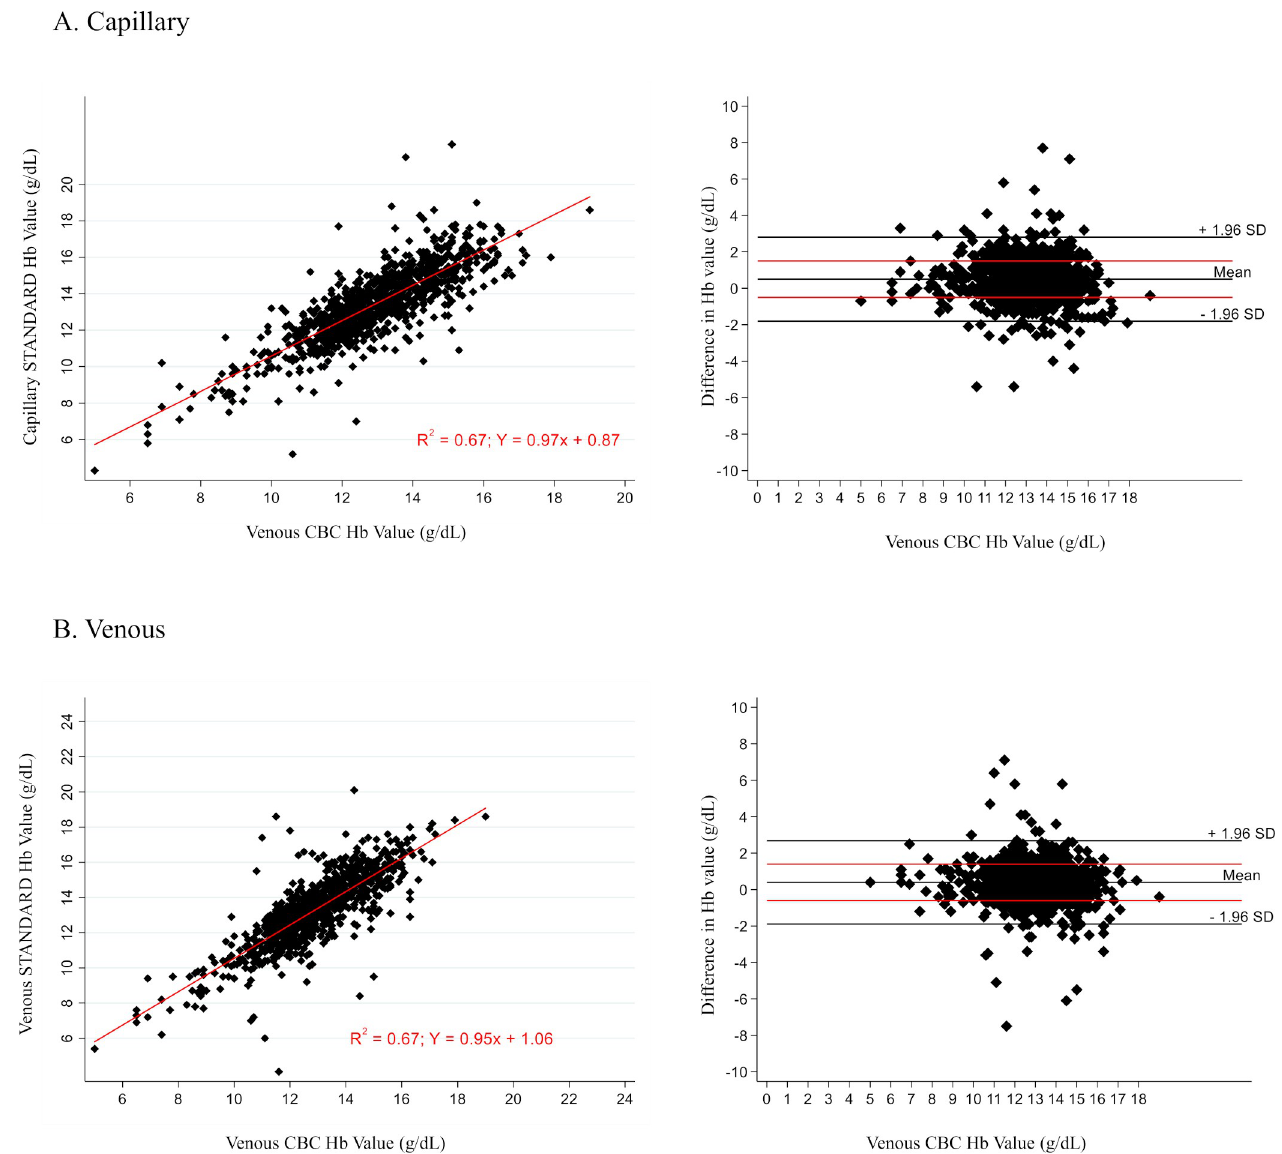
Fig 4. Regression analysis of STANDARD G6PD Test total hemoglobin measurement on A) capillary specimens compared to complete blood count, B) venous specimens compared to complete blood count (Manaus only). CBC, complete blood count; Hb,